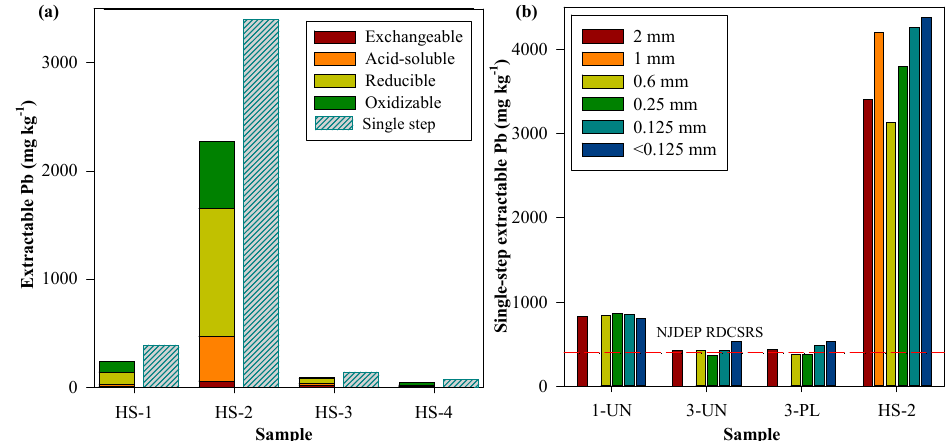
Figure 4. Pb concentration in ( a ) Tessier sequential and 1 M HNO 3 single-step extracted hotspot (HS) samples; ( b ) 1 M HNO 3 single-step extracted particle size fractions of HS-2 compared to uncultivated soil from site 1 (1-UN) and uncultivated soil and a parking lot sample from site 3 (3-UN, 3-PL) also subject to particle size analysis.